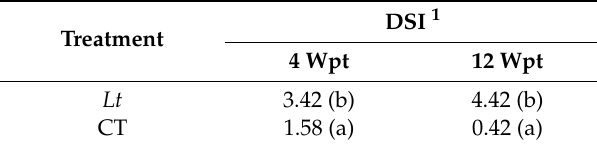
Table 1. Disease severity index (DSI) after the application of Cidely ® Top on naturally-infested mango trees cv. Sindhri in the field ( n =